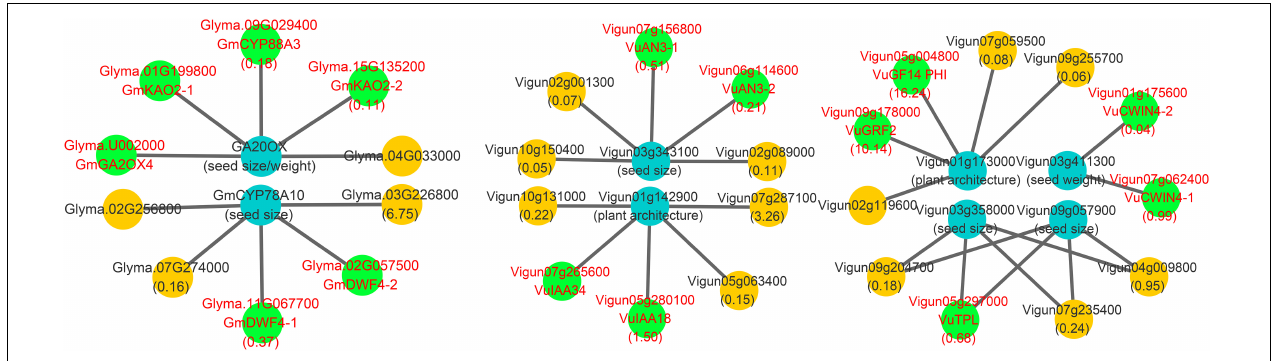
FIGURE 6 | Main interaction networks on yield-related genes in soybean and cowpea. All the genes that encode CYP88A gene family, gibberellin oxidase , 22 α hydroxylase , 14-3-3 gene family, CWIN4 , and AN3 were marked by red color characters and green background.